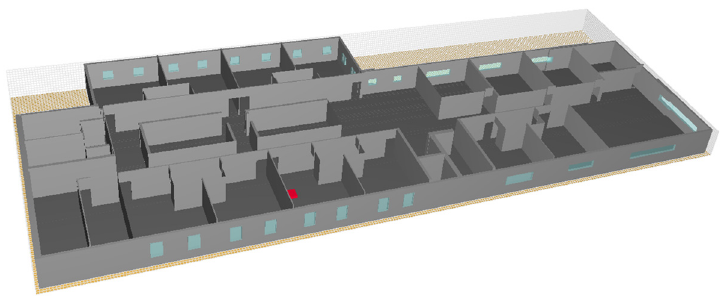
Figure 4. Analysis model for fire simulation. Table 2. Input characteristics of fire